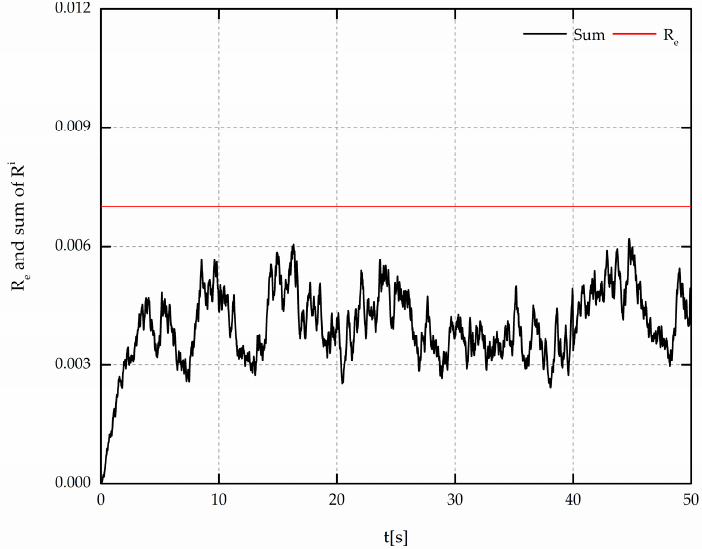
Figure 4. Comparison between threshold and sum of indicators in the case of no fault.